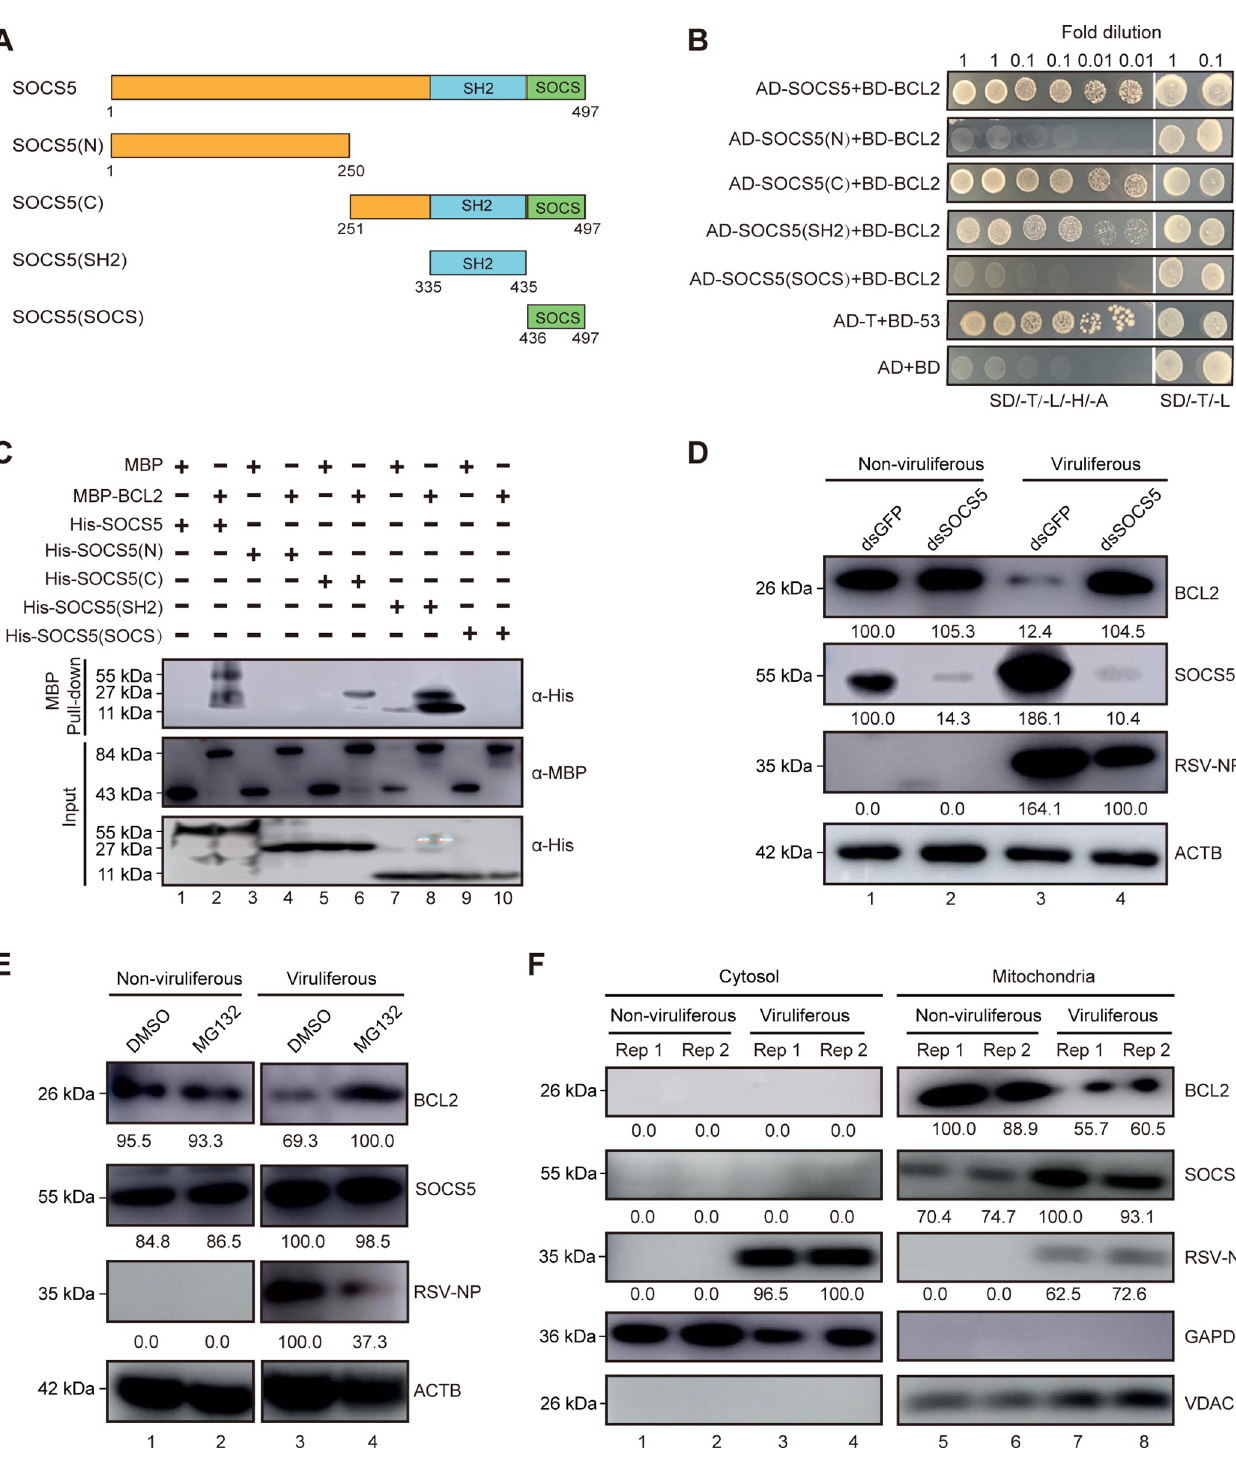
PLOS Pathogens| https://doi.org/10.1371/journal.ppat.1011266 March 16,